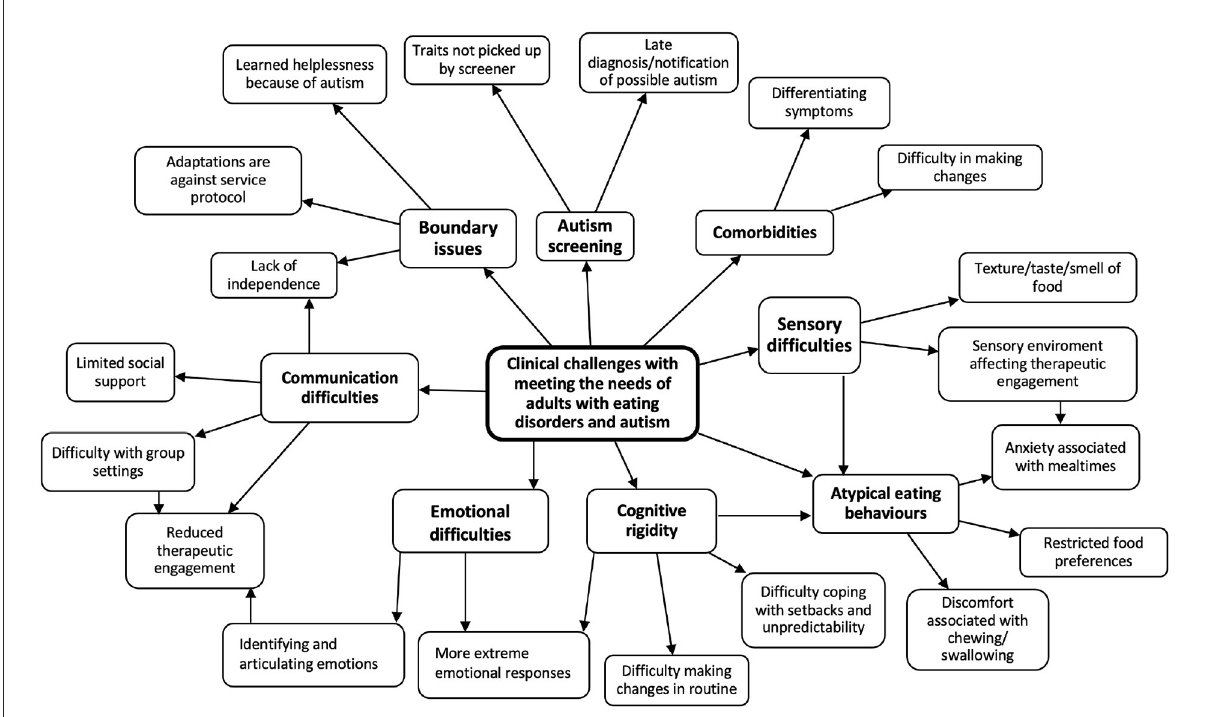
FIGURE1 Thematic map: clinical challenges with meeting the needs of adults with eating disorders and